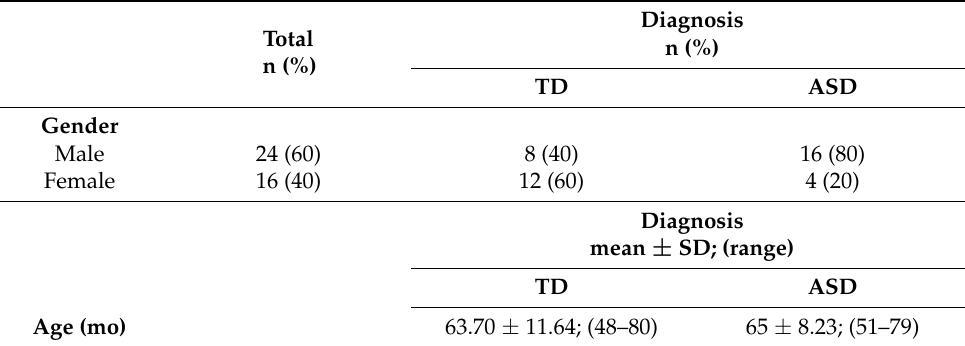
Table 1. Means, standard deviations, n and percentages of gender and age. Total n (%) Gender Male 24 (60) 16 (80) Female